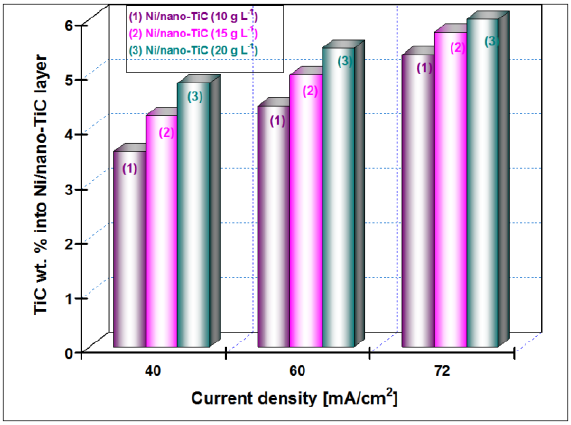
Figure 8. The degree of nano-TiC inclusion into nickel matrix depending on the current density at the time of codeposition of 30 min and different concentration of TiC nanoparticles added to the nickel electrolyte.